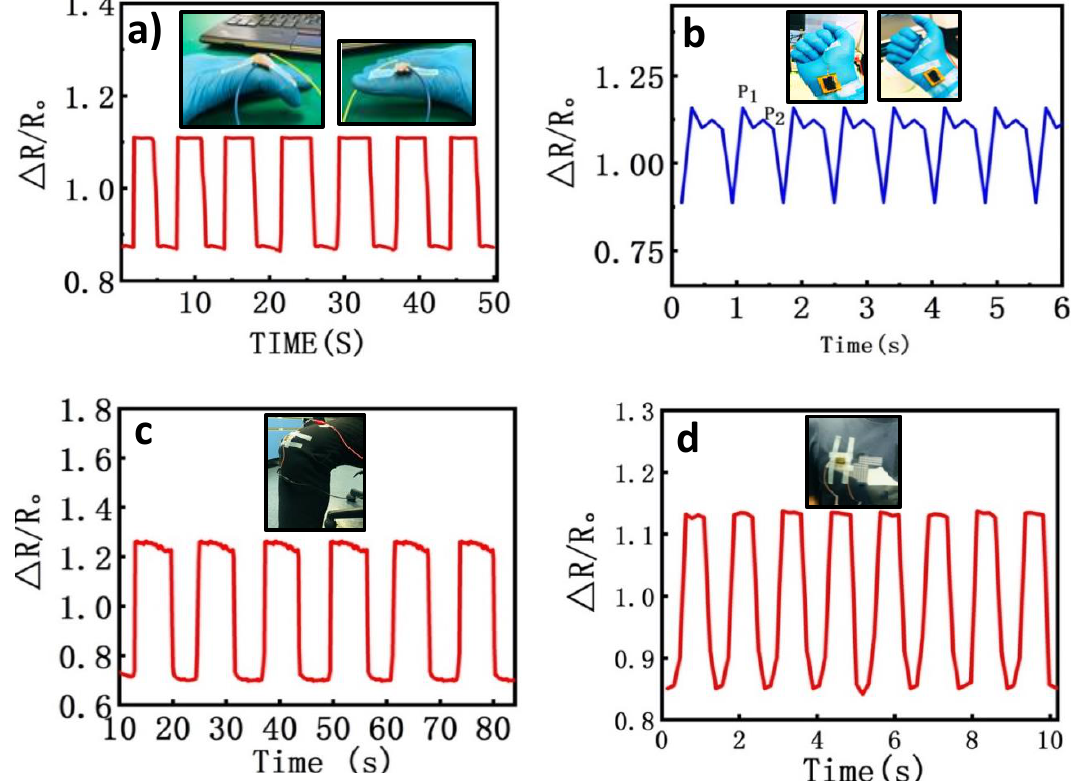
Figure 7. Schematic diagram of the piezoresistive tactile sensor in detecting different human physical signals. ( a ) Heart-rate pulses by attaching the sensor to a finger; ( b ) detection wrist pluses; ( c ) knee bending; ( d ) detection of the respiration rate.